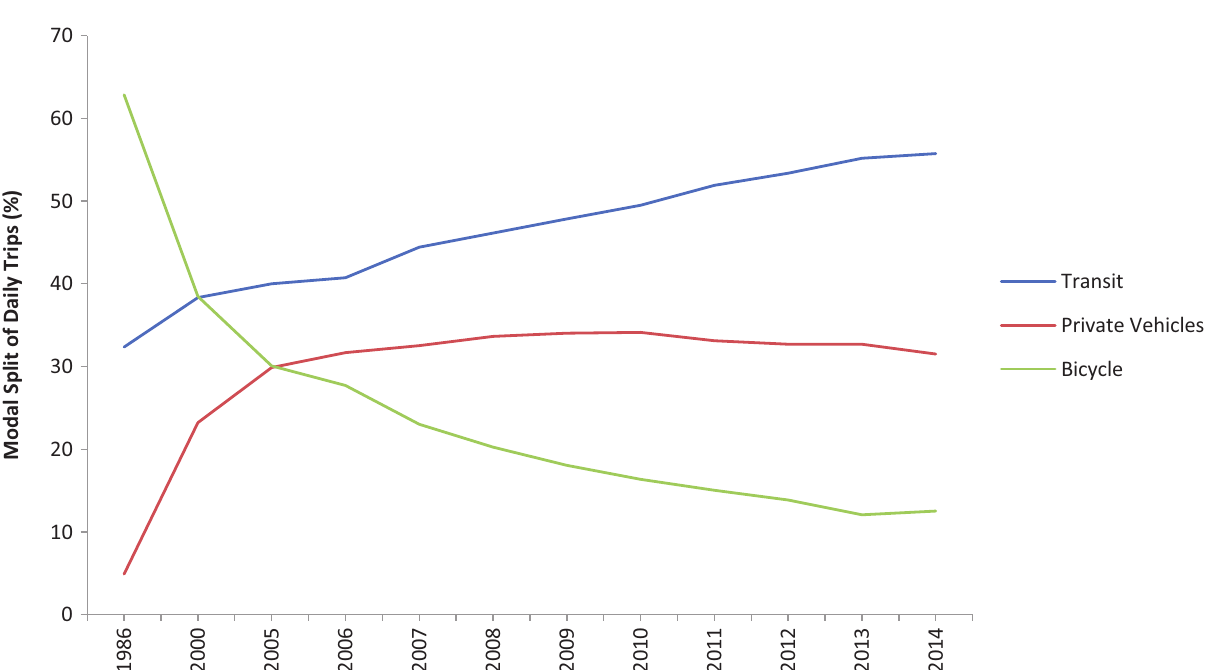
Figure 4. Modal split of daily trips in Beijing (excluding walking). Source: Compiled based on data provided by the Beijing Transportation Research Centre (BJTRC, 2002–2014, 2015).